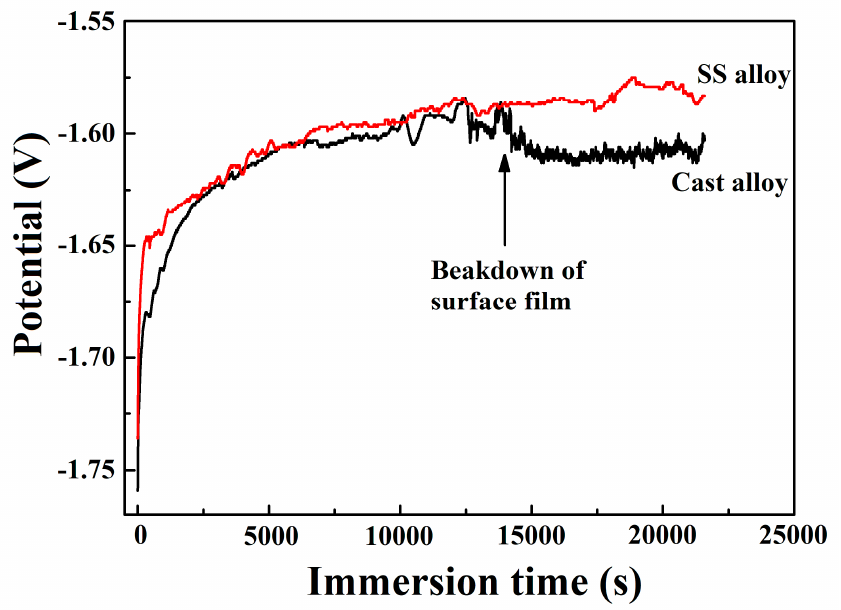
Figure 5. Open circuit potential (OCP) curves of the Mg-9Li alloys during the initial immersion in 0.1 mol/L NaCl solution.